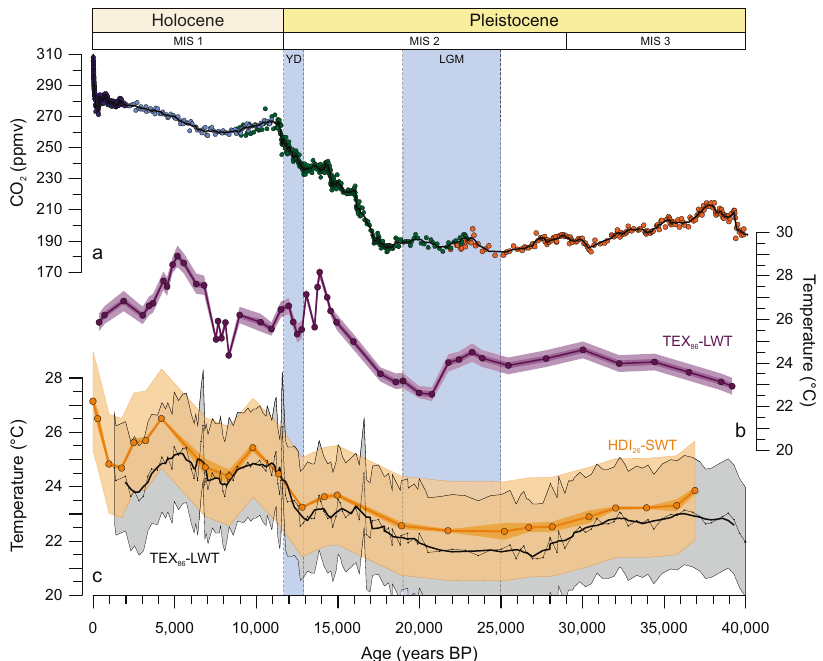
Fig. 6 Downcore plot of HDI 26 -reconstructed surface water temperatures in Lake Tanganyika in comparison with global CO 2 records and regional records of East African deglacial warming. Pro fi les are plotted as follows: a Deglacial CO 2 record from the Dome Concordia (Dome C) and other ice cores 47 . b Tropical Lake Malawi TEX 86 lake water temperature (LWT) record 49,50 . Light and dark purple shaded areas denote 68% and 95% con fi dence intervals of the reconstruction based on bootstrapping of the respective calibration 56 . c HDI 26 -based surface water temperature (SWT) record and TEX 86 -LWT record 57 in tropical Lake Tanganyika. Light blue shading denotes the age range of the regional last glacial maximum (LGM), de fi ned by 10 Be ages of moraines from the Rwenzori Mountains 69 , and the Younger Dryas (YD) cold event 54 . The gray shaded area indicates the calibration uncertainty associated with the TEX 86 . The calibration uncertainty of the HDI 26 is indicated in light orange, while the analytical error based on replicate measurements is shown in dark